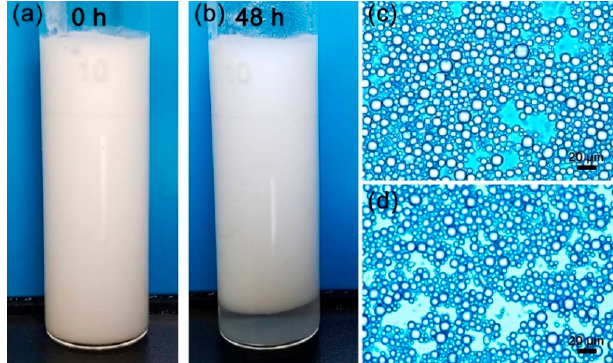
Figure 2. Microstructure of SiO 2 nanospheres: ( a ) SEM image and ( b ) TEM image. The average size in diameter was ~76 nm.